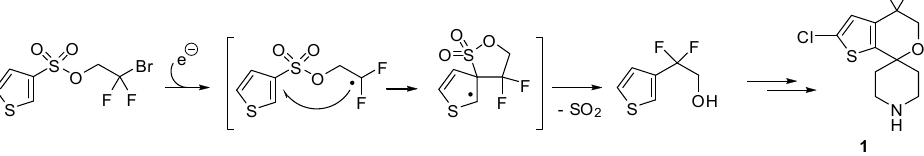
Scheme 2. Application to the synthesis of difluoro-substituted spirocyclic ORL-1 antagonist.